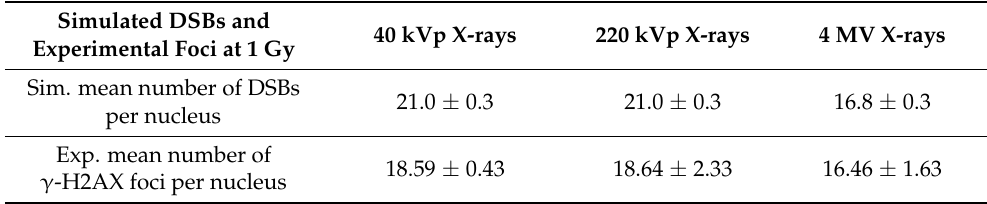
Table 5. Comparison of the simulated results and the experimental for a dose of 1 Gy for different X-ray beams: mean number of γ -H2AX foci per endothelial cell nucleus in Gap0/Gap1 (30 min post-irradiation) and mean number of simulated DSB per nucleus, reproduced from